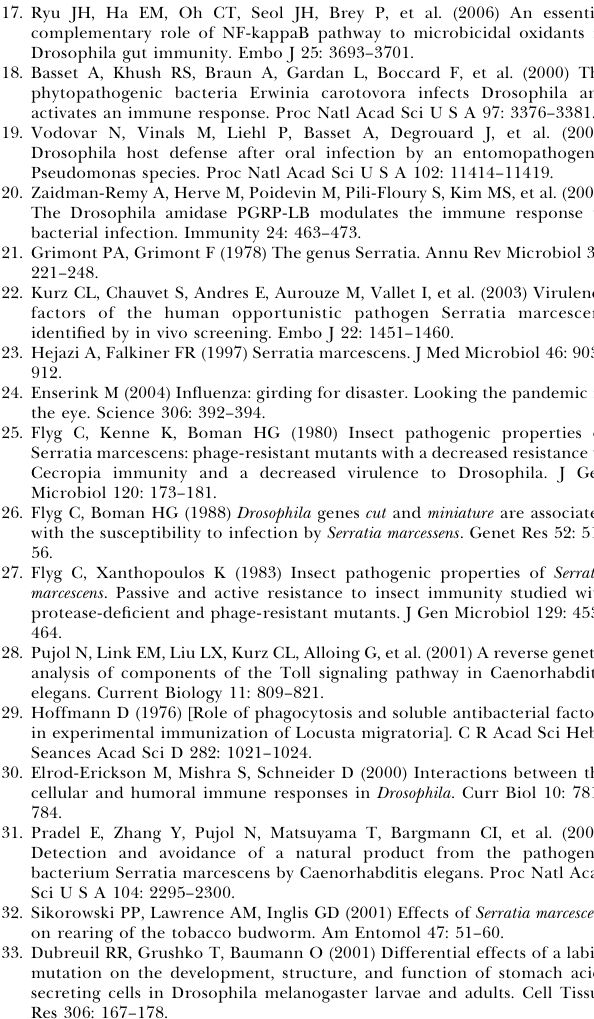
Figure S8. Flies Injected with Cytochalasin D Are More Susceptible to Db11 Oral Infections Flies challenged by a Db11 septic injury (si) die at the same rate whether they have or have not been pre-injected with cytochalasin. Flies injected with cytochalasin die earlier than nontreated control flies that are just starting to succumb when this survival experiment was stopped. Cytochalasin is not toxic to the flies since they survive normally, like PBS-injected flies. DMSO was used to dilute the cytochalasin and is not toxic at the concentration used. Oregon flies were used in this experiment. Table S1. Expression Patterns of AMP Reporter Genes during Db11 Oral Infections Found at doi:10.1371/journal.ppat.0030173.st001 (31 KB DOC). Table S2. Bacterial Proliferation in the Hemolymph of Latex Bead– Treated Flies in the Absence of a Gut Bacterial Supply Counts of bacteria present in the intestine or hemolymph from 20 uninjected or latex bead–injected (LXB) wild-type Oregon flies after 24 h of Db11 feeding followed by 24 h feeding on gentamicin-sucrose solution. Found at doi:10.1371/journal.ppat.0030173.st002 (31 KB